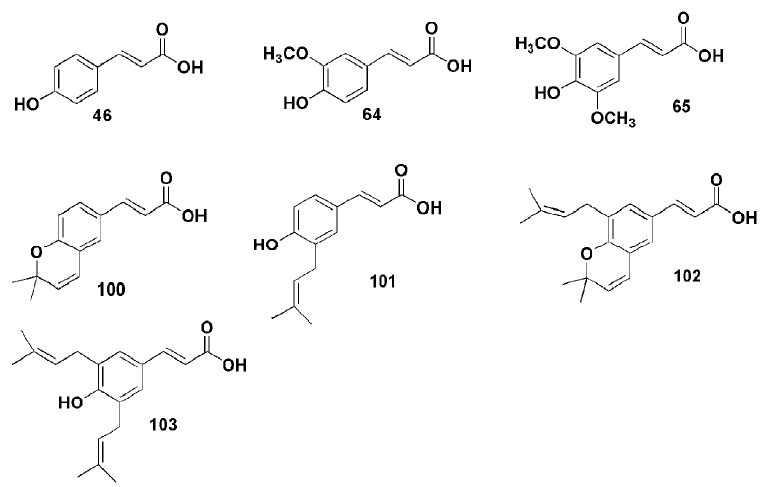
Figure 28. Chemical structures of compounds 46, 64, 65, 100-103 [73].